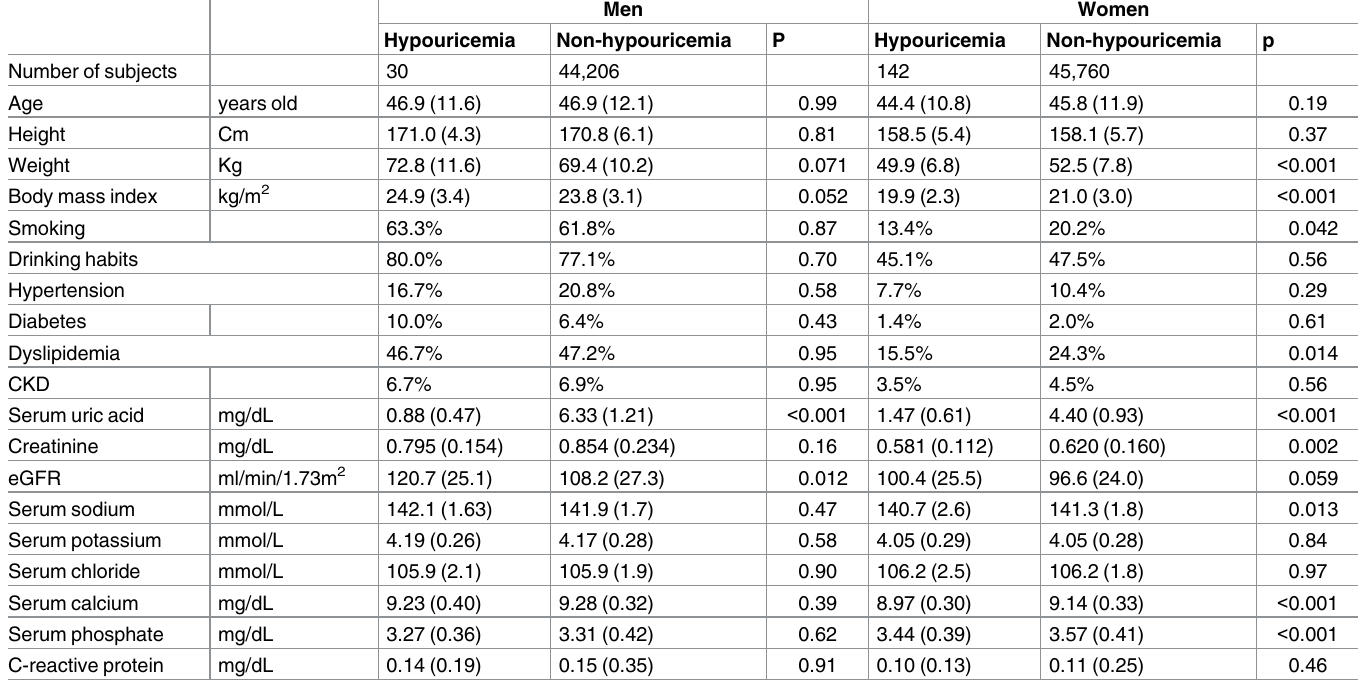
Table 2. Characteristics of the study subjects by sex.